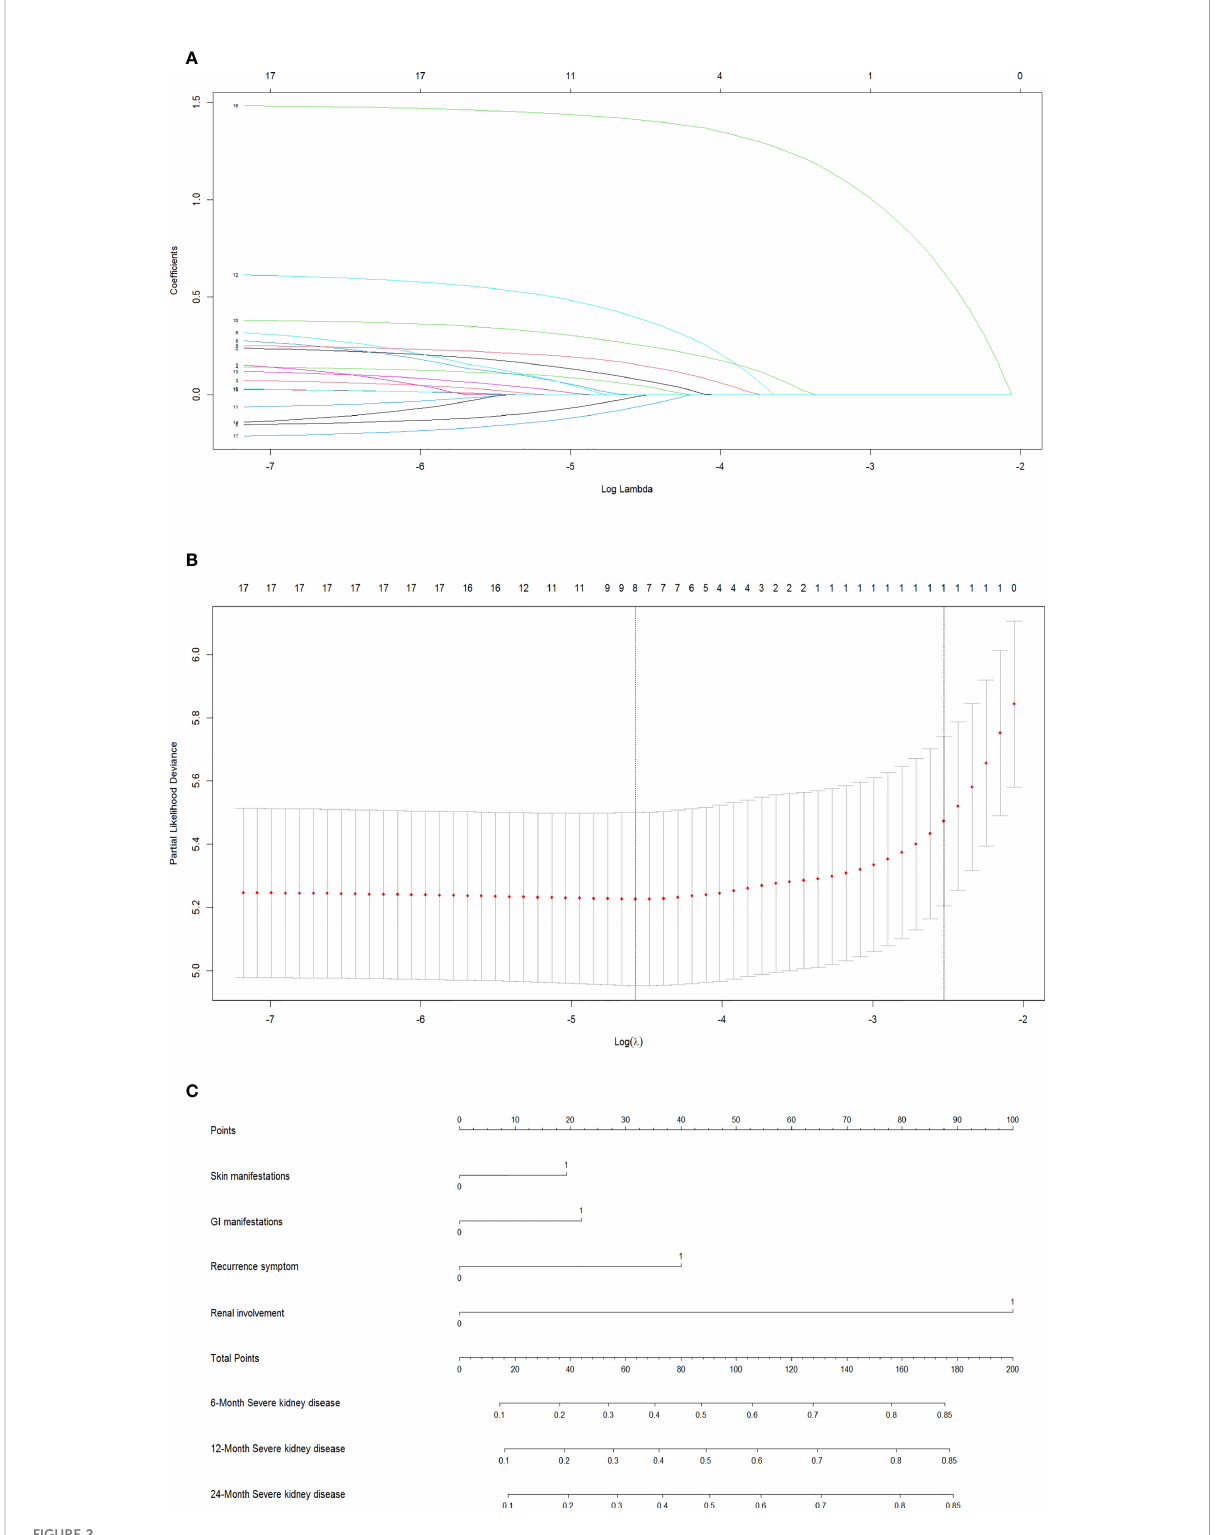
FIGURE 2 Screen the in fl uencing factors using LASSO regression and estimate probability of SKD by nomogram. The punishment process of the model (A) . The change process of the best punishment coef fi cient l in LASSO regression model (B) . Nomogram to estimate probability of SKD at 6, 12, and 24 months (C) . LASSO, least absolute shrinkage and selection operator; SKD, severe kidney